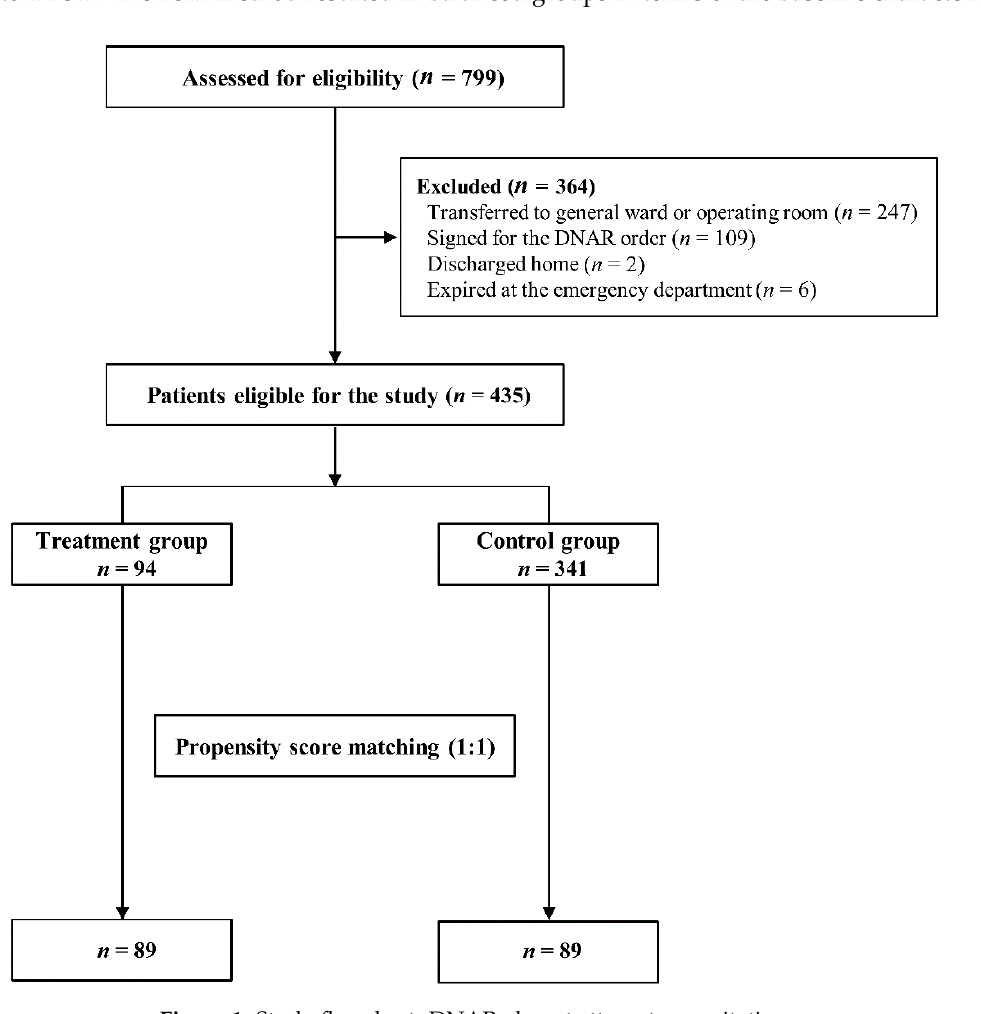
Figure 1. Study flowchart. DNAR, do not attempt resuscitation.